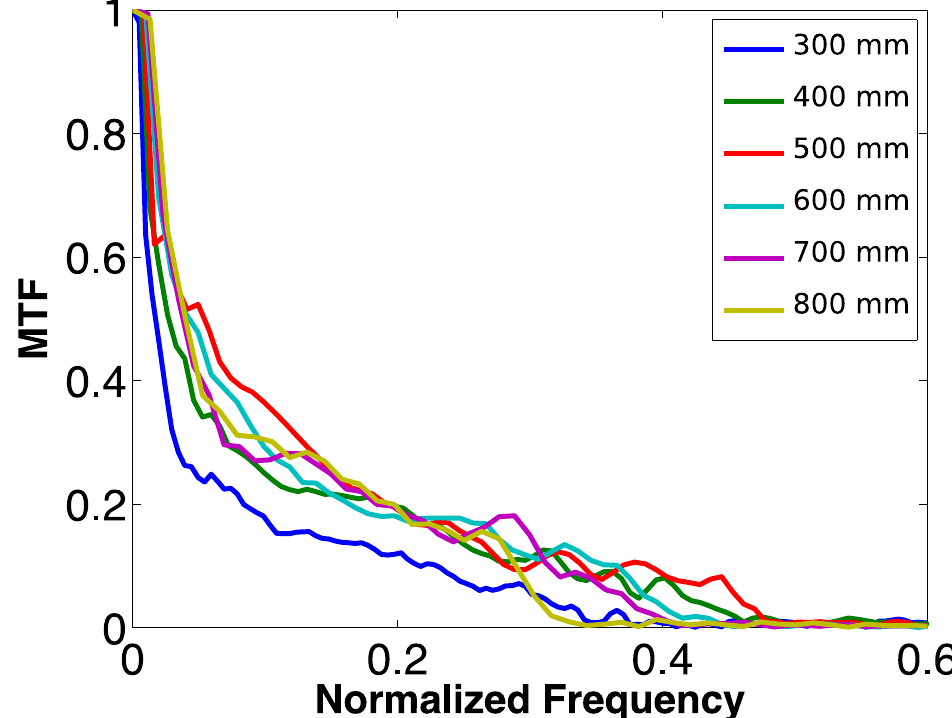
Figure 8. MTFs computed, in the horizontal direction, from the experimental measurement of the edge-spread function obtained optically in each 𝑧′ position. edge-spread function obtained optically in each z (cid:48)